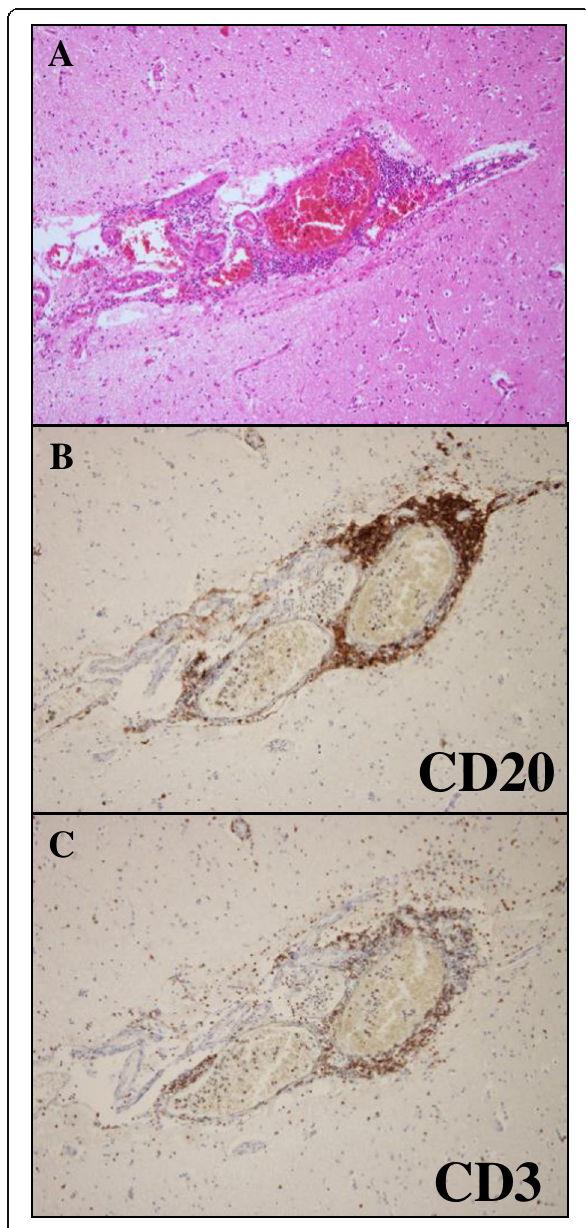
Fig. 4 Histological images of the brain. Lymphocyte infiltration into the perivascular space of the brain tissue. B cells were the dominant component of the lymphocyte infiltrates. a Hematoxylin and eosin staining. b Immunohistochemistry for CD20. c Immunohistochemistry for